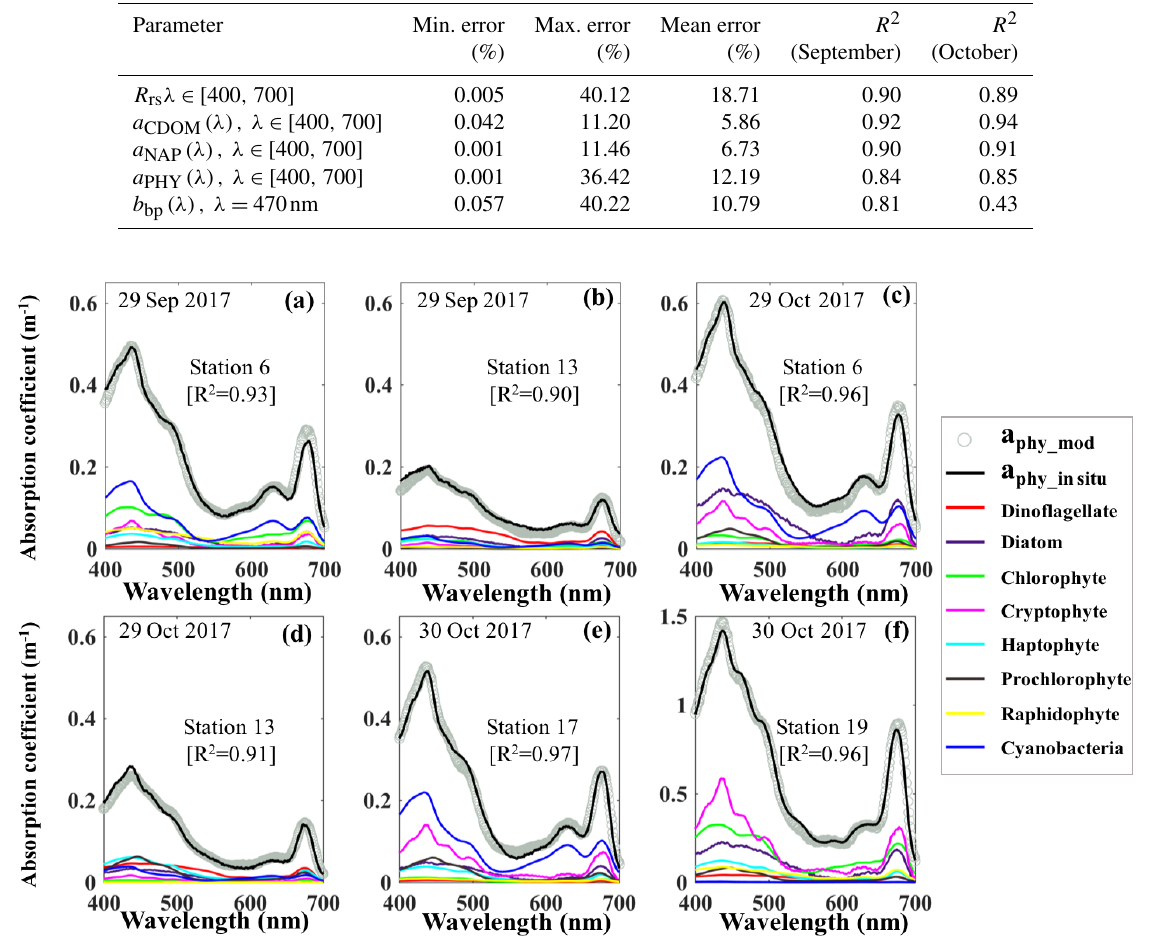
Figure 5. Reconstruction of phytoplankton absorption coefficients spectra at stations 6 (a) and 13 (b) on 29 September 2017, at stations 6 (c) and 13 (d) on 29 October 2017 and at stations 17 (e) and 19 (f) on 30 October 2017 based on the mass-specific absorption spectra of different phytoplankton groups including diatoms, chlorophytes, dinoflagellates, cryptophytes, cyanobacteria (blue), haptophytes, prochlorophytes and raphidophytes presented using different